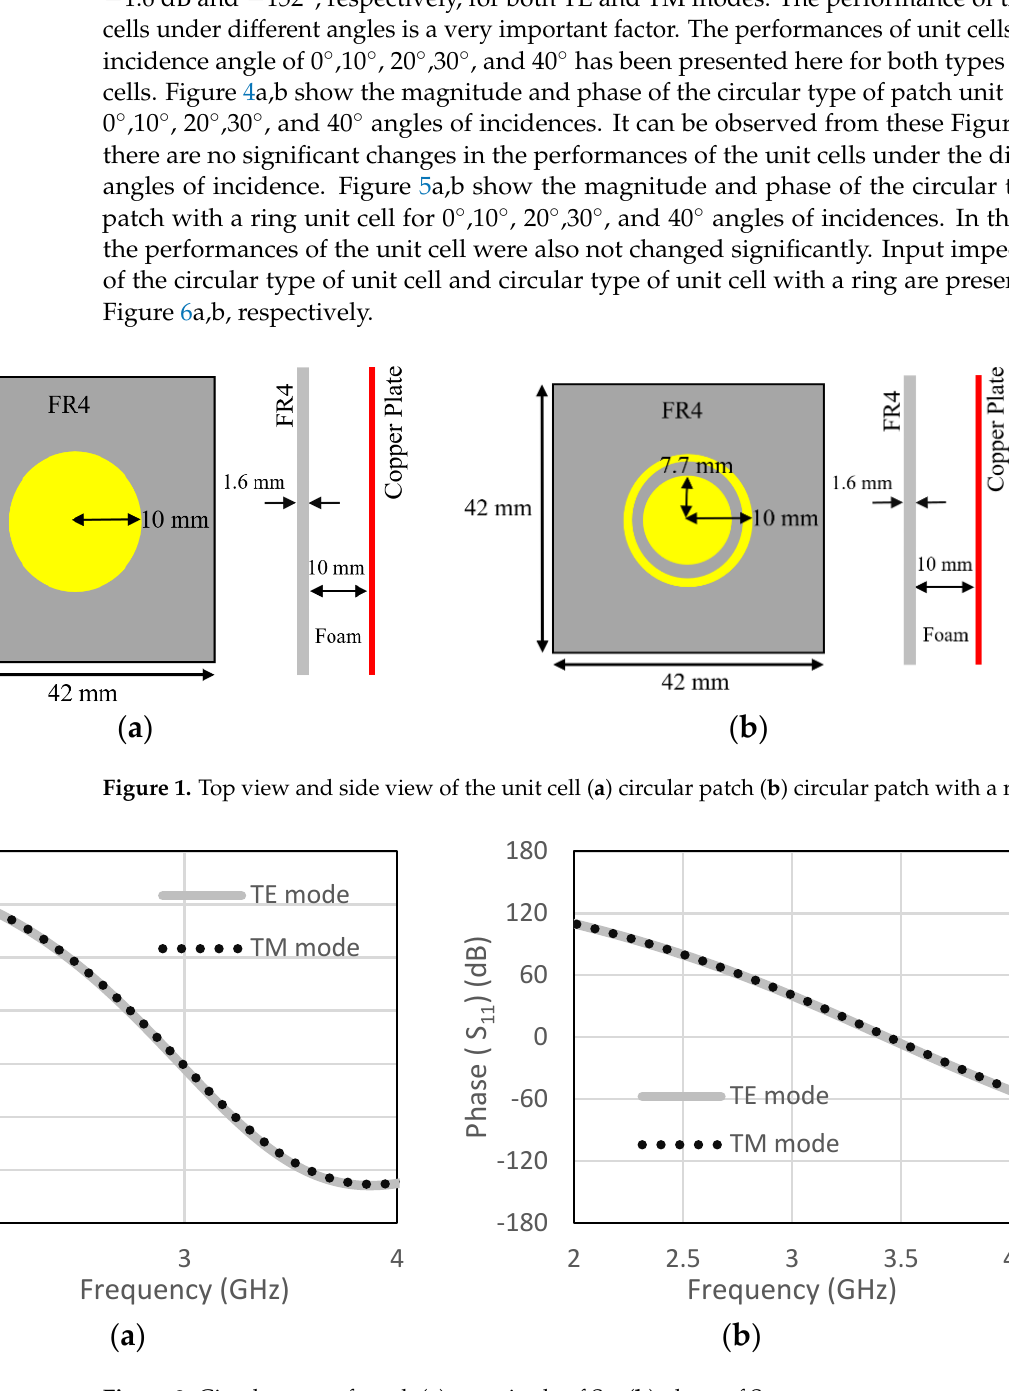
Micromachines 2022 , 13 , x